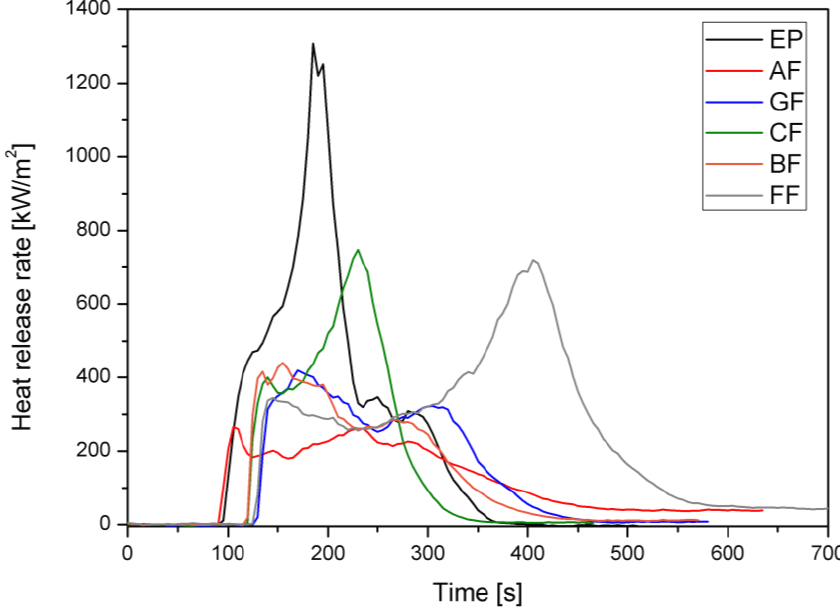
Figure 13. Heat rate release for EP and EP-based composites reinforced with various fibers.